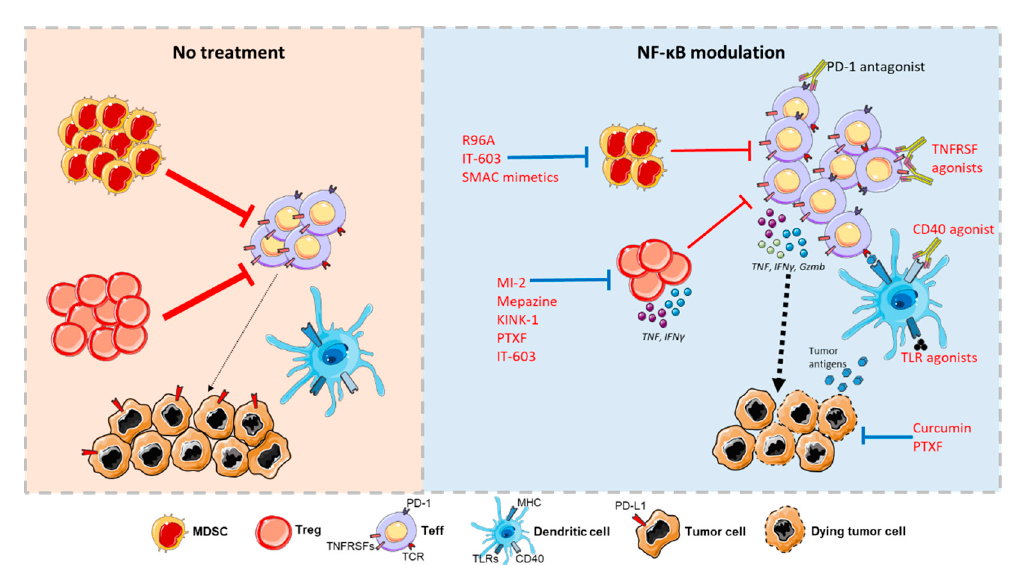
Figure 2. Proposed mechanism for the immunotherapeutic effects of NF- κ B modulating agents. In the absence of treatment, MDSCs and Treg cells actively inhibit CD4 + and CD8 + Teff cells; tumor-derived Ag presentation by DCs is low. NF- κ B inhibitors increase the numbers and activity of Teff cells by decreasing the recruitment and fitness of MDSCs and impairing Treg cell identity, relieving the suppression of Teff cells. Moreover, these treatments reduce PD-L1 expression and induce tumor cell death, leading to enhanced Ag-presentation by DCs. Conversely, stimulation of TNFRSFs and TLRs on DCs and Teff cells activates NF- κ B to increase their maturation numbers and function. All these agents potentiate the therapeutic effect of anti-PD-1 mAbs. Some figure elements were obtained from Servier Medical Art (https://smart.ser- vier.com/).